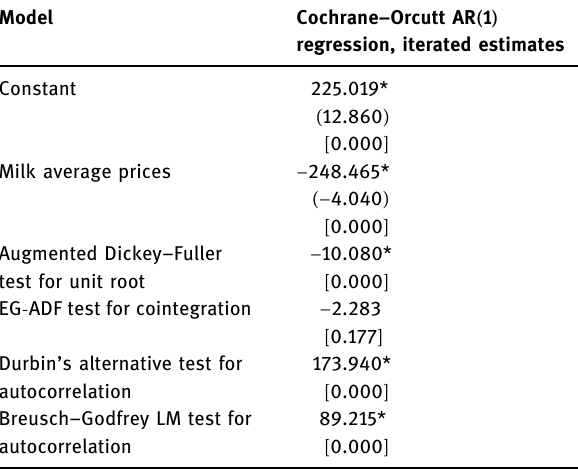
Table 1: Results for times series regression between the raw cows ’ milk delivered to dairies ( millions kilograms ) and the average prices ( euro/kg ) , for the months of the period 2005 – 2019